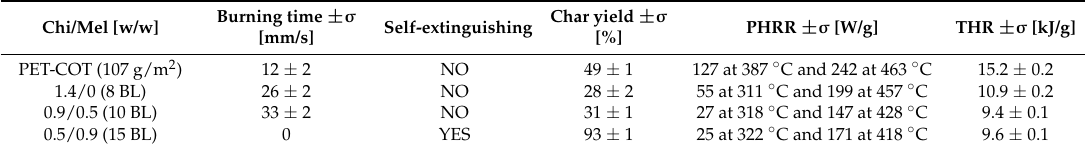
Table 19. Flammability and PCFC data for PET-COT (107 g/m 2 ) treated by chitosan,